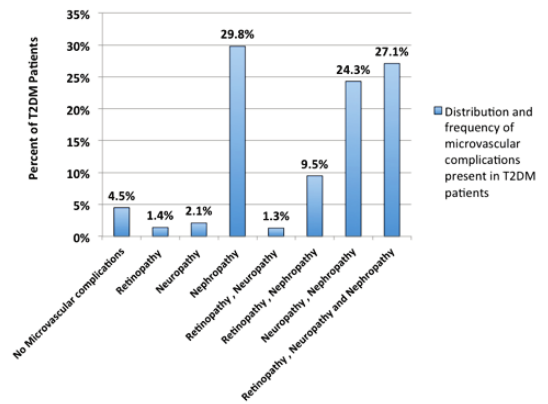
Figure 1. Bar chart demonstrating the prevalence of microvascular complications among type 2 diabetic patients. As illustrated, diabetic nephropathy represents a corner stone complication in the majority of patients, often in combination with other microvascular complications